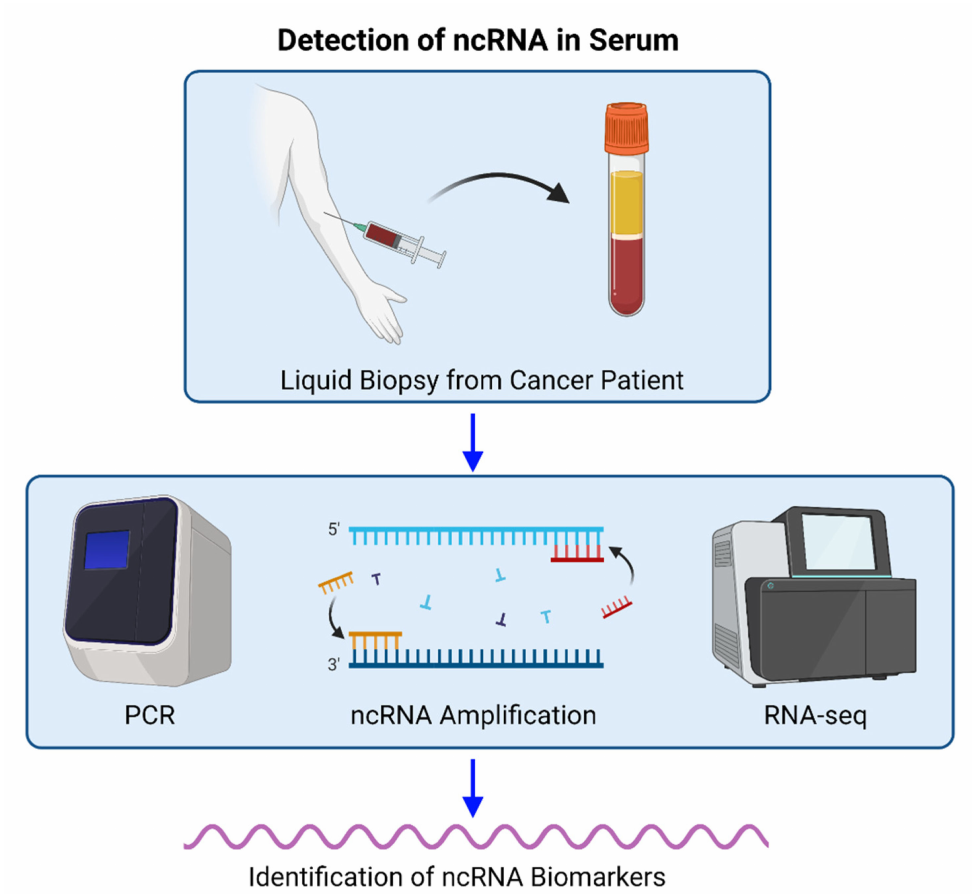
Figure 2. Circulating non-coding RNA biomarkers discovery for diagnostic or prognostic prediction of BC. Blood of patients is processed to obtain serum, non-coding RNAs are amplified through PCR (either quantitative real-time PCR or digital droplet PCR). Biomarkers for prediction are discovered based on their correlation with patients’ survival or response to